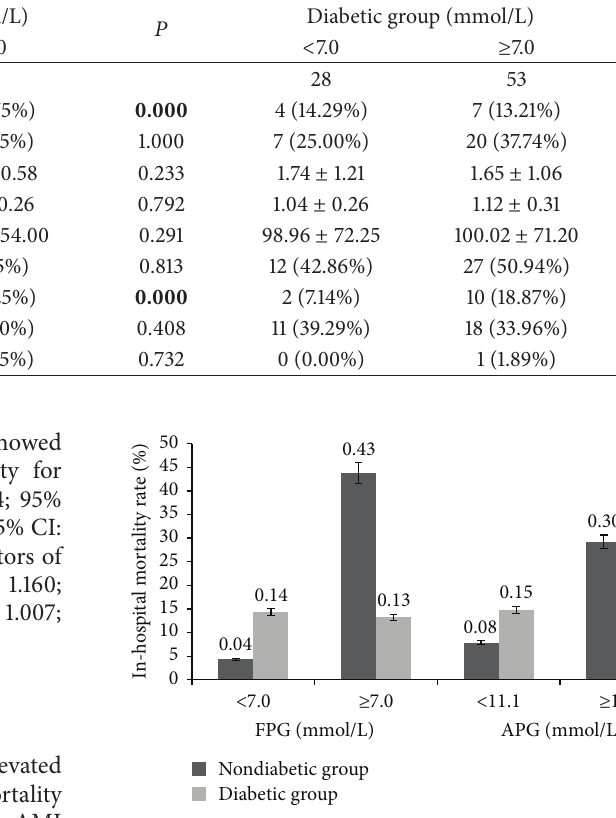
fasting hyperglycemia. Compared with patients categorized as having normal FPG, the adjusted OR for 30-day mortality progressively increased with higher tertiles of elevated FPG (first tertile: 4.6; 95% CI: 1.7 to 12.7; second tertile: